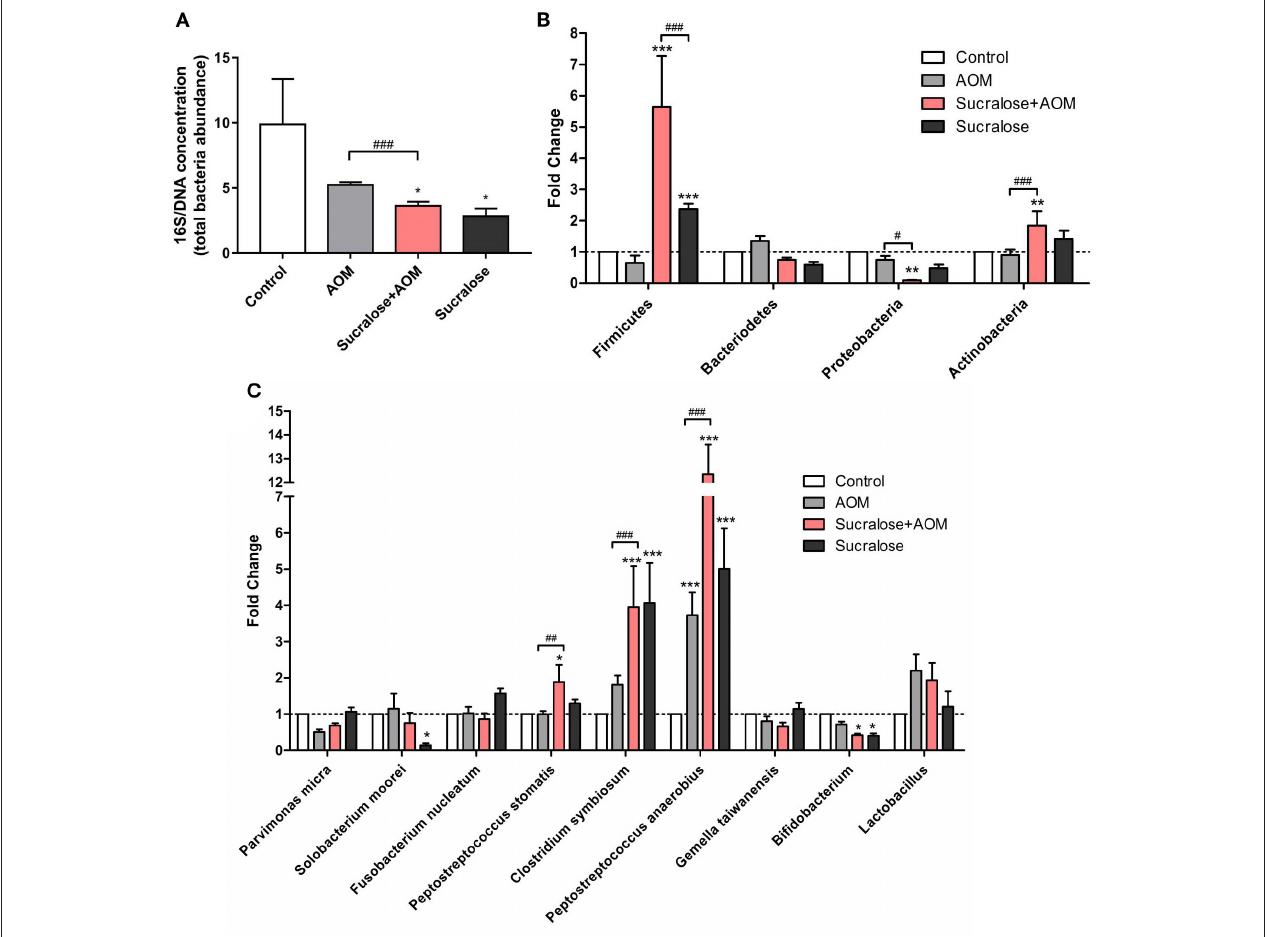
FIGURE 4 | Sucralose alters mouse fecal microbiota composition. (A) Changes in 16S/DNA concentration. (B) Changes in Firmicutes, bacteriodetes, proteobacteria, and actinobacteria. (C) Changes in Parvimonas micra, Solobacterium moorei, Fusobacterium nucleatum, Peptostreptococcus stomatis, Clostridium symbiosum, Gemella , and Peptostreptococcus anaerobius . Compared with the control group: * P < 0.05, ** P < 0.01, *** P < 0.001; compared with the AOM group: # P < 0.05, ## P < 0.01, ### P < 0.001, n = 8.